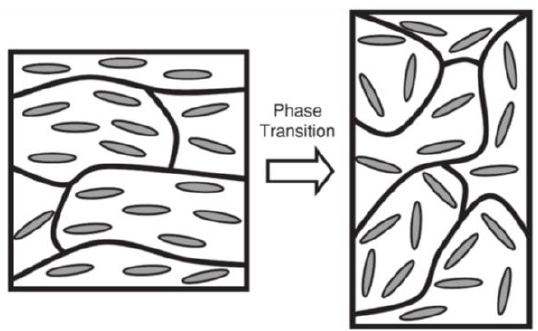
Figure 3. The concept of LCEs as artificial actuator for mimicking muscle. Reprinted with permission from Reference [40]. Copyright 2010, Wiley ACH Advanced Materials.